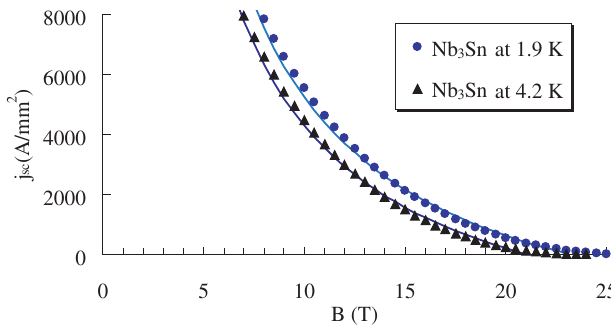
FIG. 28. (Color) Critical surface for Nb according to Kramer law (markers), and fit given in Eq. (40) (solid line).